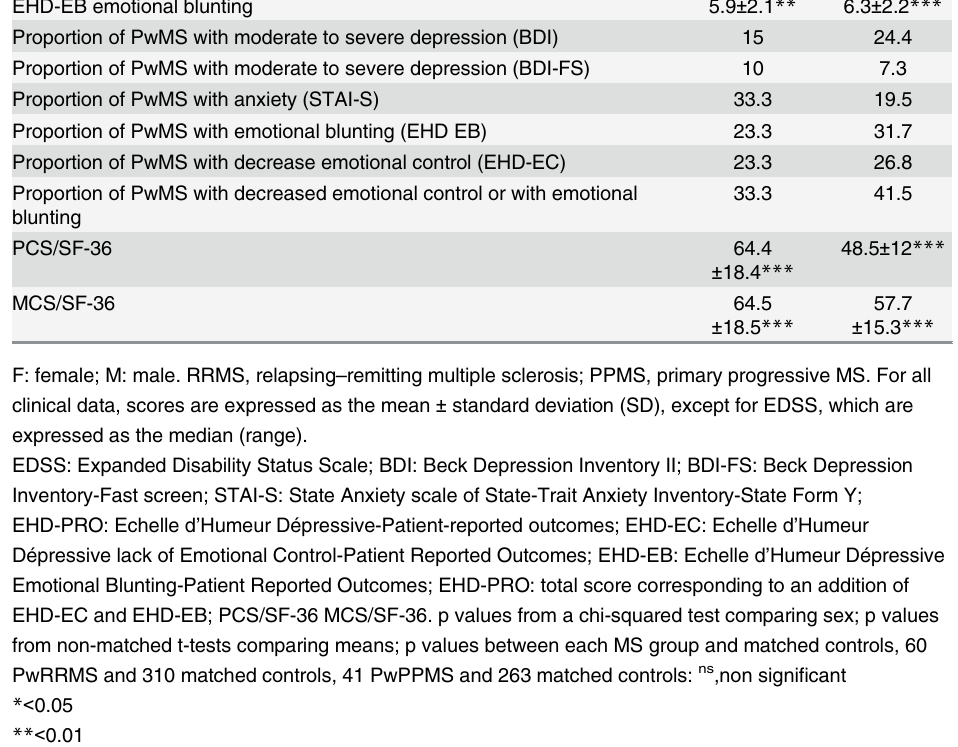
EHD-EB emotional blunting Proportion of PwMS with moderate to severe depression (BDI) Proportion of PwMS with moderate to severe depression (BDI-FS) Proportion of PwMS with anxiety (STAI-S) Proportion of PwMS with emotional blunting (EHD EB) Proportion of PwMS with decrease emotional control (EHD-EC) Proportion of PwMS with decreased emotional control or with emotional blunting